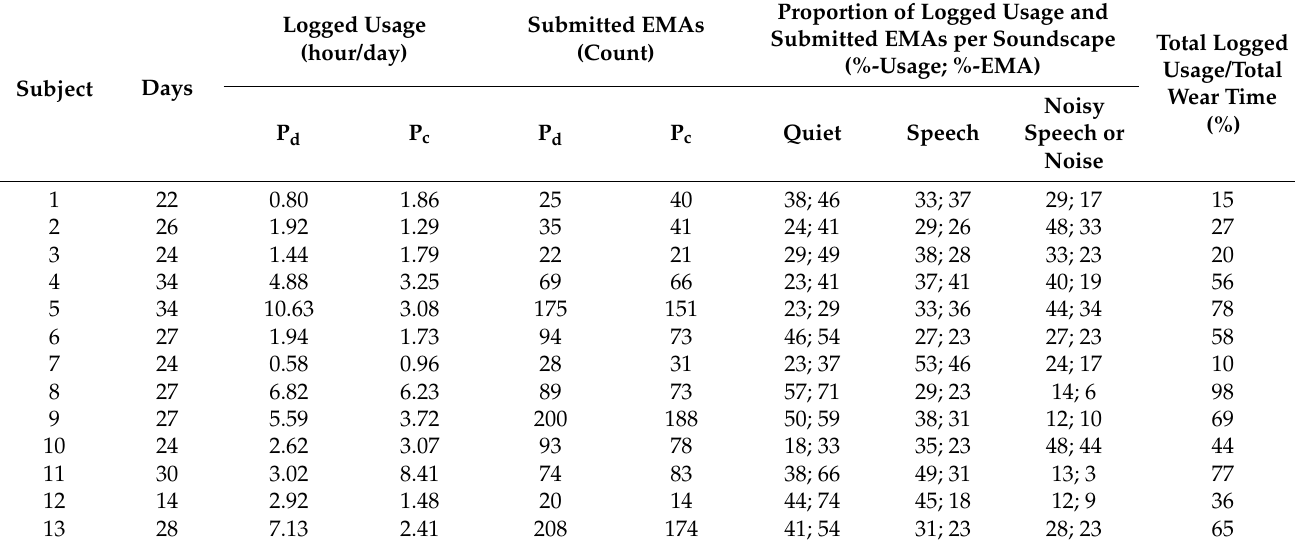
Table 2. Data logging summary. Columns from left to right: subject, logged usage for both the default listening program (P d ) and the custom program (P c ) in hours per day, the absolute number of submitted EMA’s per listening program, the proportion of submitted EMAs for the soundscapes Quiet, Speech, Noisy speech or noise, and usage logged on the smartphone divided by total device uptime (i.e., proportion of device uptime with smartphone